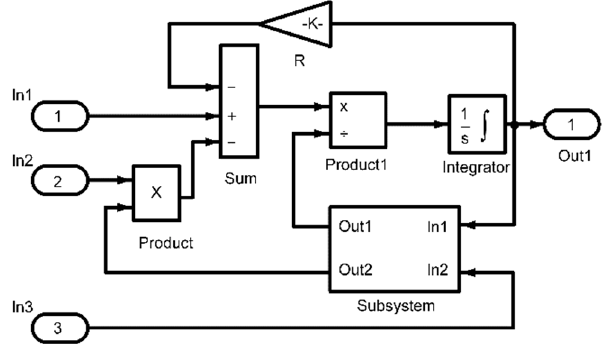
Figure 9. Phase current calculation module.